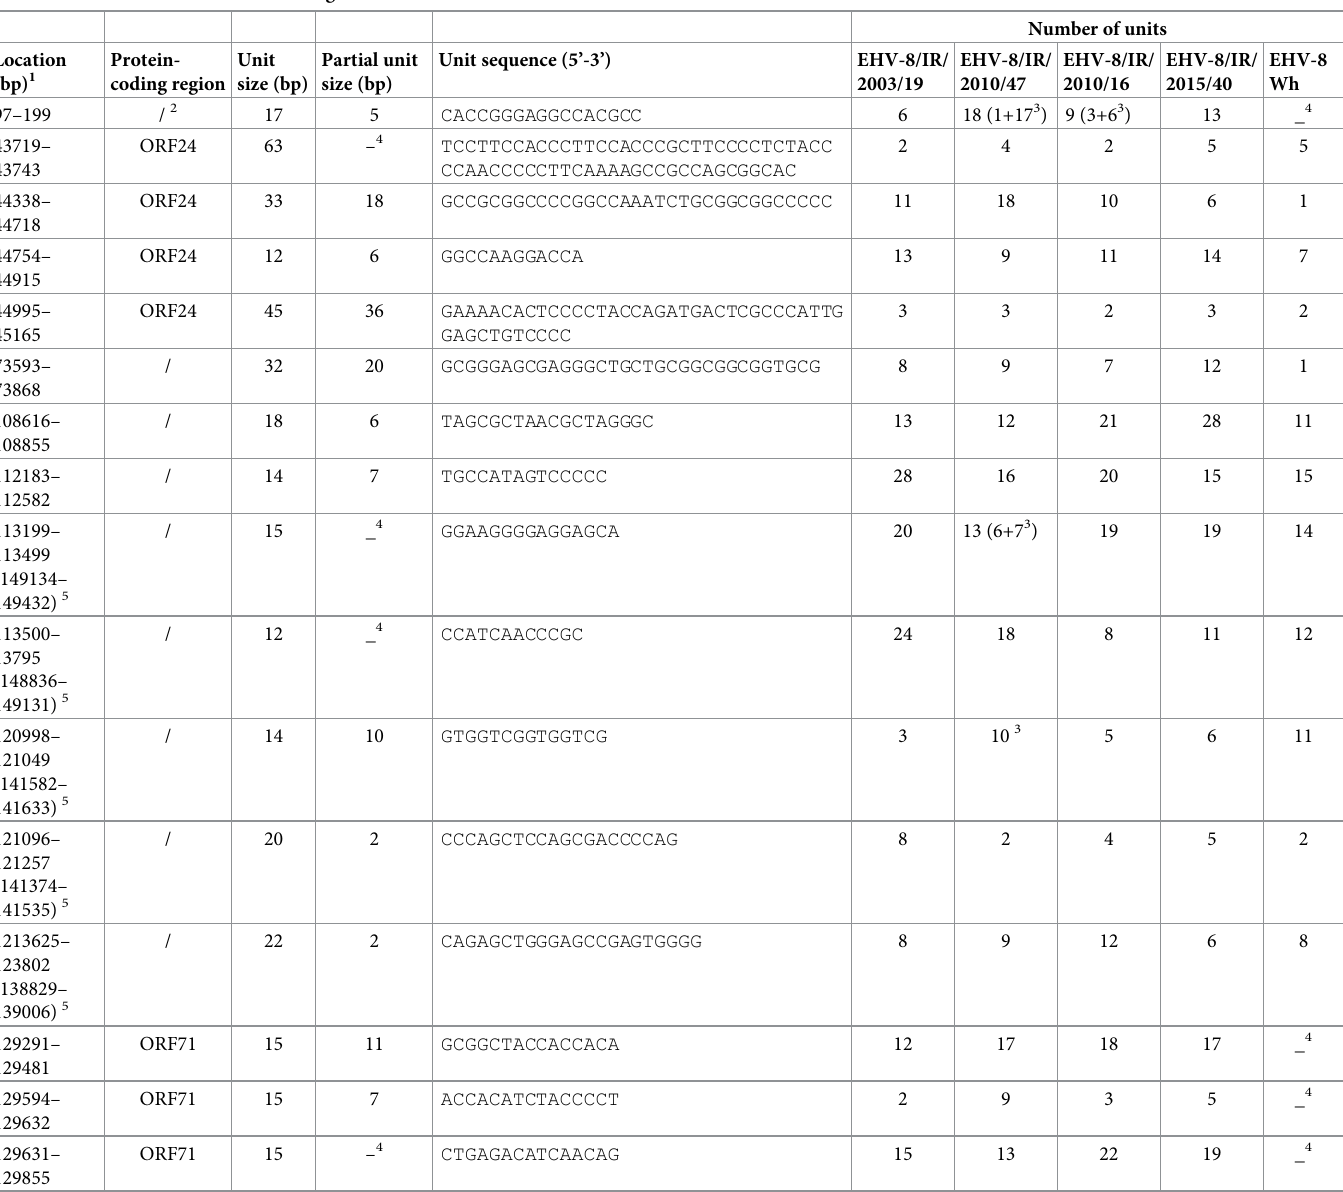
Table 2. Tandem reiterations in EHV-8